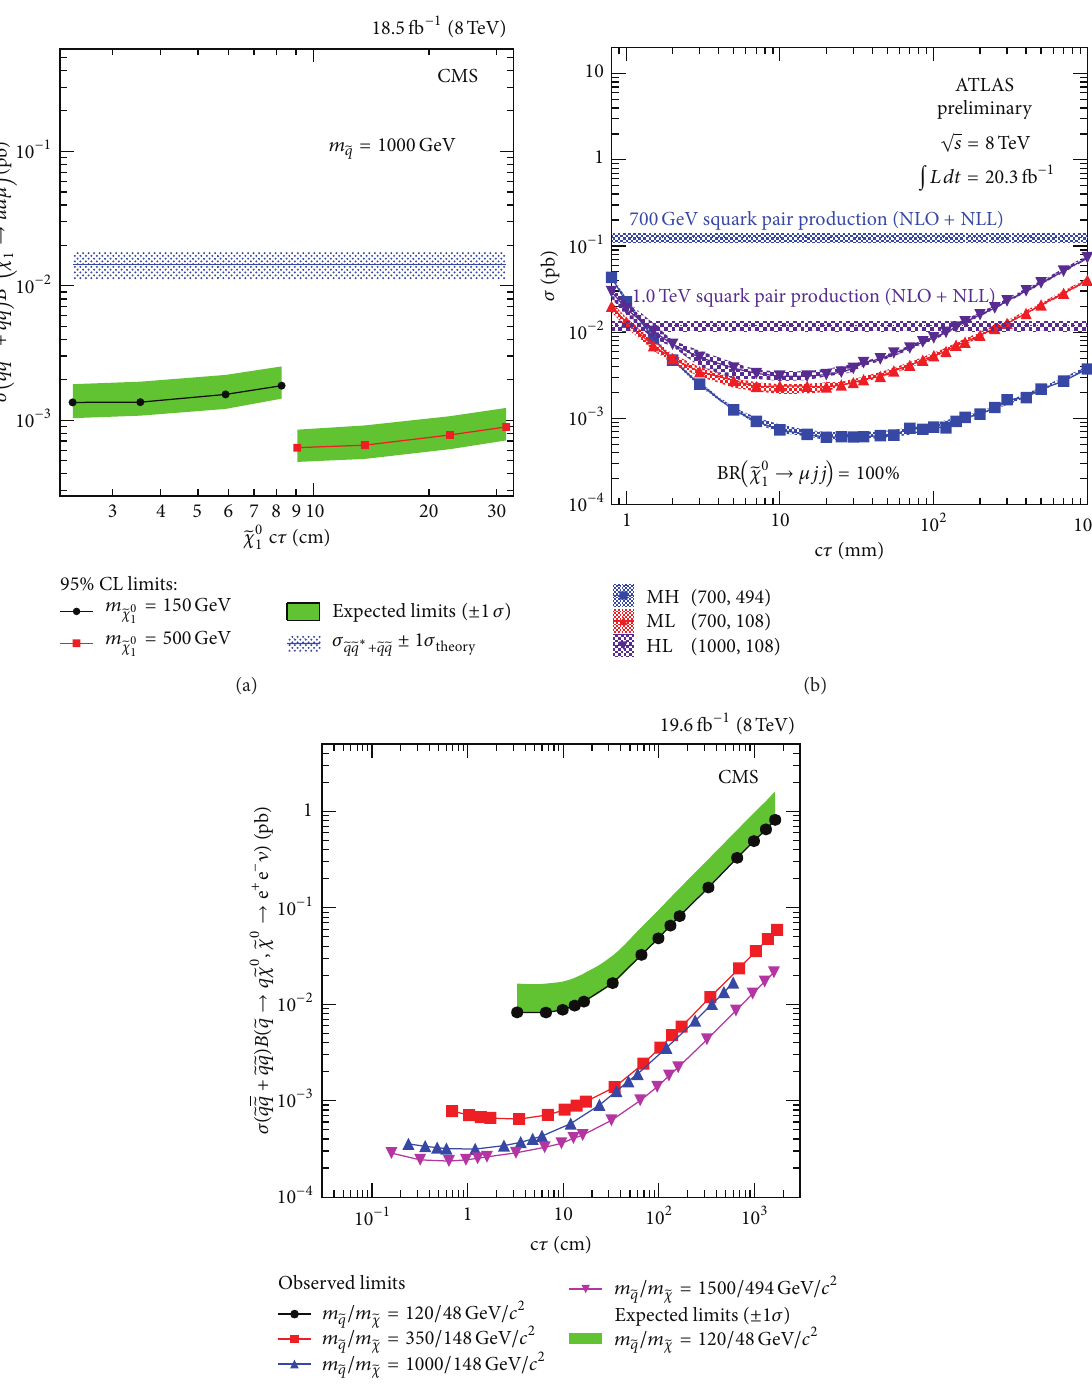
Figure 10: Limits on displaced RPV supersymmetry for LQD coupling from displaced jets [16] (a), displaced muon + tracks events [17] (b), and for LLE coupling from displaced same-flavor dileptons [18] (c). In all panels, each colored line represents an example of new physics spectrum for which the cross section indicated in the vertical axis is excluded at 95% Confidence Level under the assumption of the lifetime indicated in the corresponding horizontal axis. The horizontal lines are predictions for the total production cross section in new physics scenarios for new physics particles masses as labeled on each